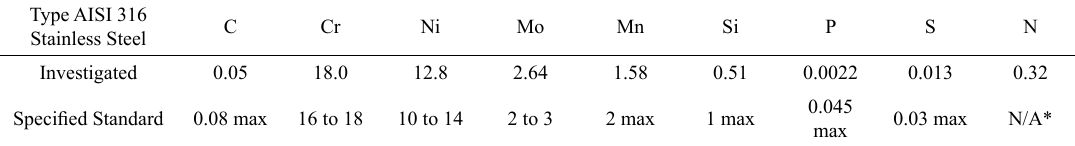
Table 1. Chemical composition (wt%) of the investigated and standard specification for the type AISI 316 stainless steel. Type AISI 316 Stainless